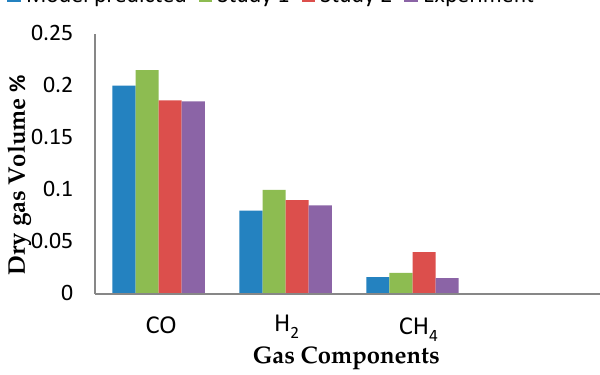
Figure 5 . Composition of the syngas predicted by model compared with experimental results.